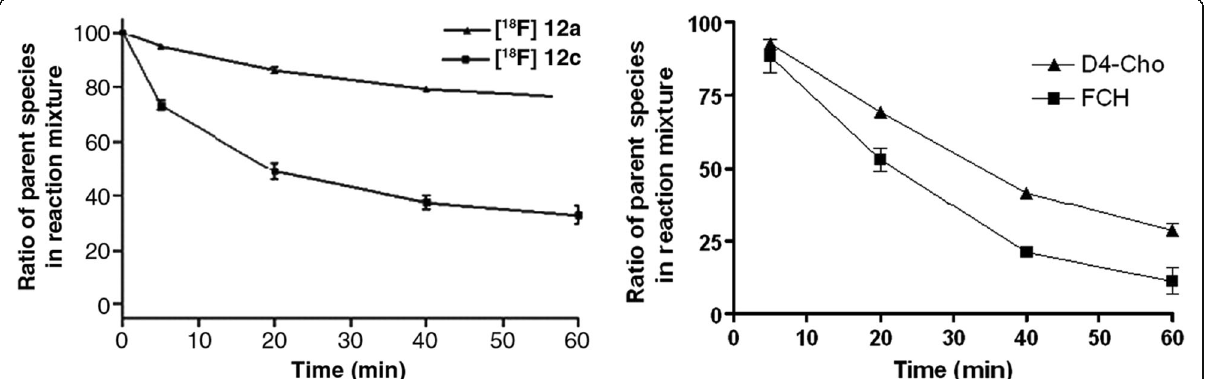
Fig. 10 a Chemical oxidation potential of [ 18 F]fluorocholine (12a) and [ 18 F] fluoro-[1,2-2H4]choline (12c) in the presence of potassium permanganate. b Time-course stability assay of [ 18 F]12a and [ 18 F]12c in the presence of choline oxidase demonstrating the conversion of its parent compounds to their respective betaine analogs. Adapted with permission from Ref.